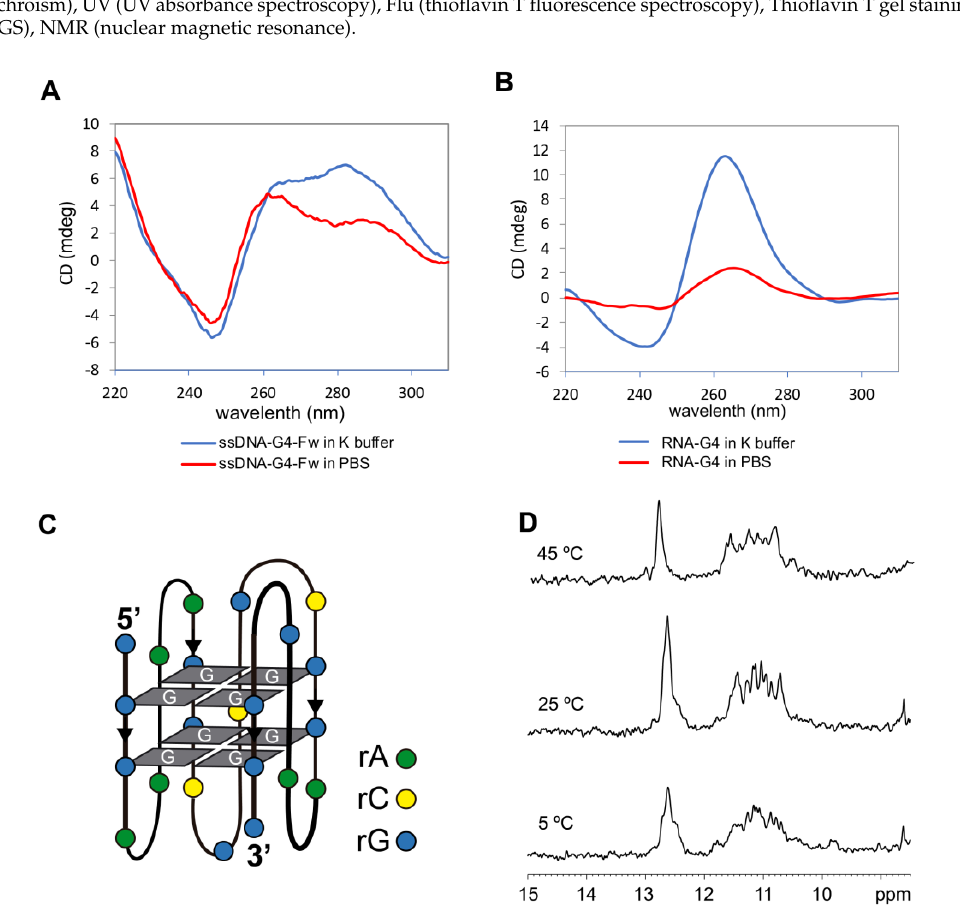
Figure 2. Structural characterization of G4FS in both RNA and DNA oligonucleotides. CD spectra of ssDNA-G4-Fw ( A ) and RNA-G4 ( B ) in K + bu ff er (blue line) and PBS (red line) at 20 ◦ C, showing a shape consistent with the formation of G-quadruplex structures. ( C ) Illustration representing the G-quadruplex folding of the G4-RNA sequence. Each color dot represents a ribonucleotide: adenine (rA), citosine (rC) and guanine (rG). ( D ) Imino region of monodimensional 1 H-NMR spectra of ssDNA-G4-Fw in H 2 O / D 2 O (90:10) at di ff erent temperatures. The spectra show signals between 10 and 12 ppm, characteristic of imino protons taking part in G-tetrads. Bu ff er conditions: 25 mM KPi pH 7, 100 mM